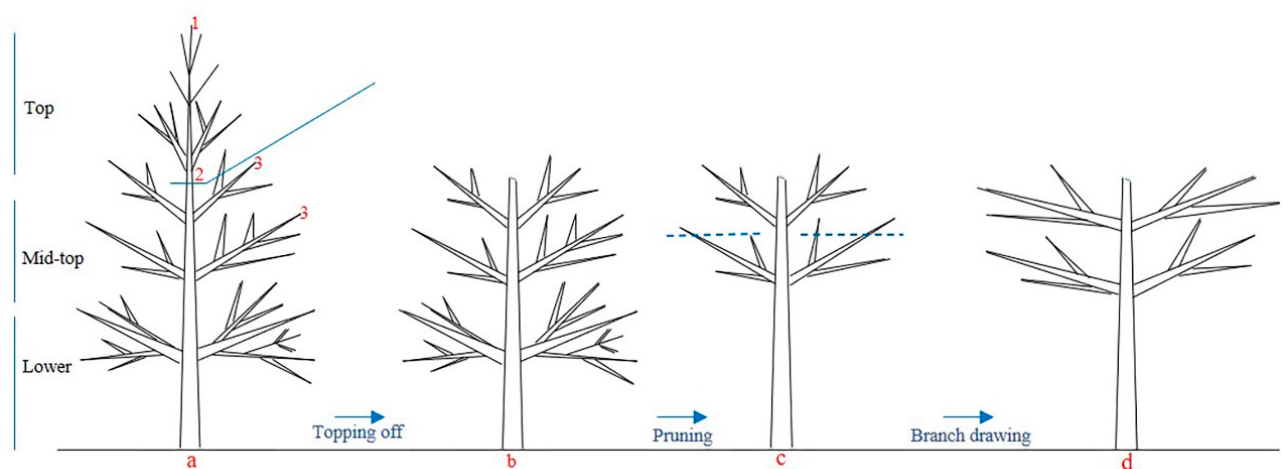
Figure 2. A schematic presentation of the topping off ( a ), pruning ( b ) and branch drawing ( c ) practices to improve flowering, panel ( d ) shows ideal tree shape, where in panel a 1 represents terminal buds, 2 represents topping off position on trunk and 3 represents lateral branch.